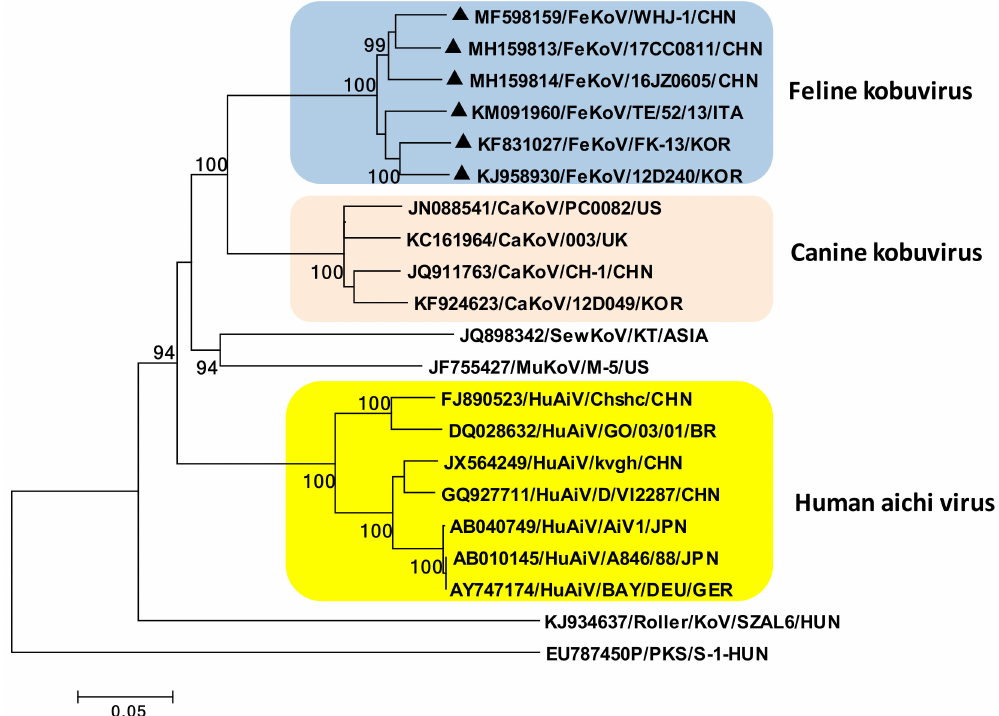
Figure 2. Phylogenetic tree based on the full-length genomic sequence of the species Aichivirus A . The tree was generated using the neighbor-joining method and the Kimura two-parameter model supplying a statistical support with bootstrapping of 1000 replicates. Black triangles indicate the FeKoV sequences. Abbreviations: FeKoV, feline kobuvirus; CaKoV, canine kobuvirus; SewKoV, sewage kobuvirus; MuKoV, murine kobuvirus sewage; HuAiV, human aichi virus; PKS, porcine